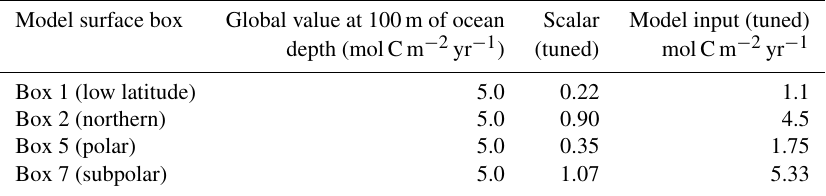
Table 1. Values for the Z biological production parameter (at 100m of ocean depth) used in the SCP-M model calibration. A global value for Z was tuned in each surface box using scalars (column 3) to yield unique values for each surface box (column